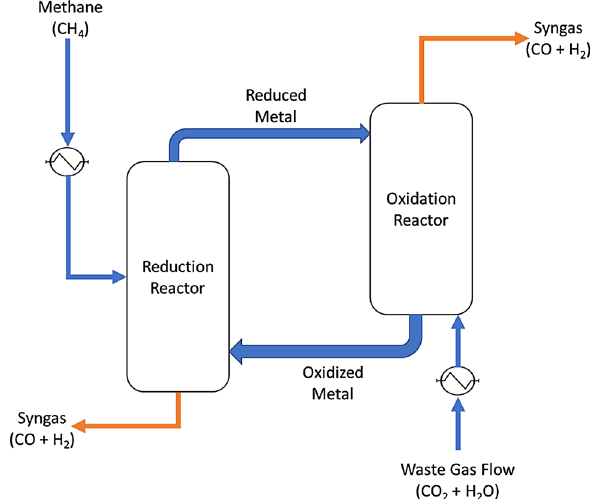
Fig. 1 Conceptual scheme of the chemical looping Syngas production through methane reduction and corresponding splitting of water and carbon